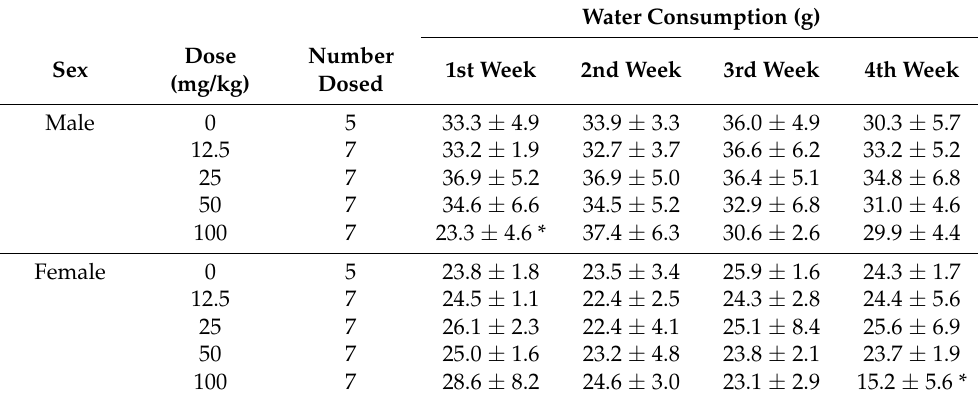
Table 4. Water consumption for the 28-day repeated oral toxicity